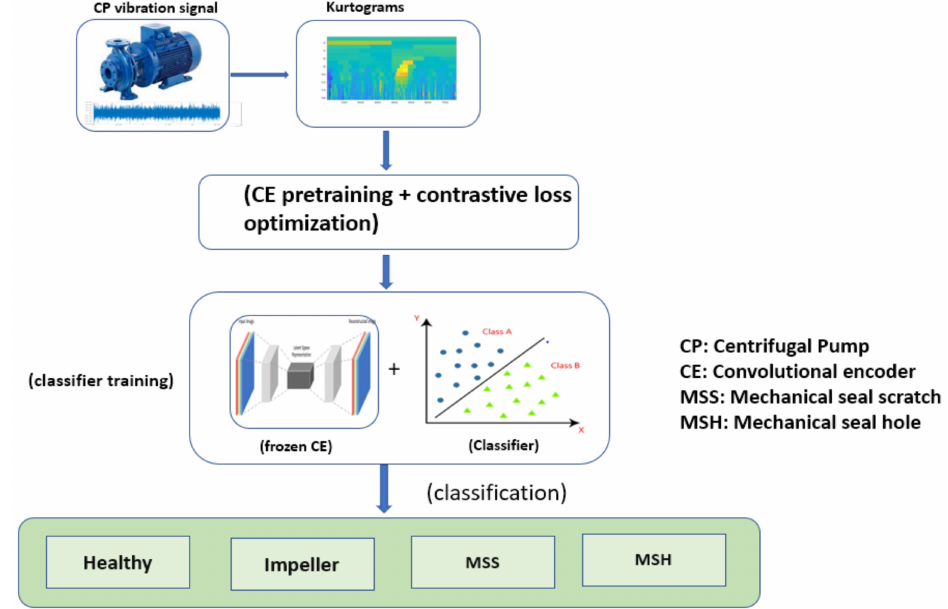
Figure 1. Flow chart of the proposed approach used for CP fault detection.